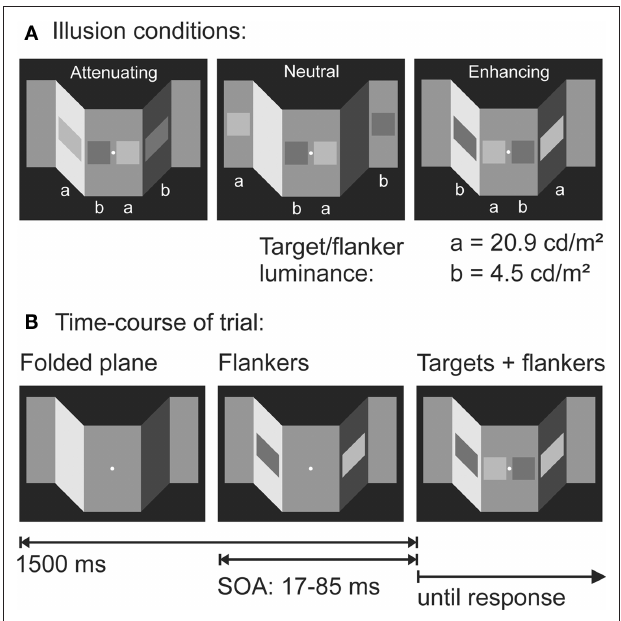
Figure 5 | Paradigm from Schmidt et al. (2010). (A) Stimulus examples. Note that target and flanker pairs have the exact same two luminance